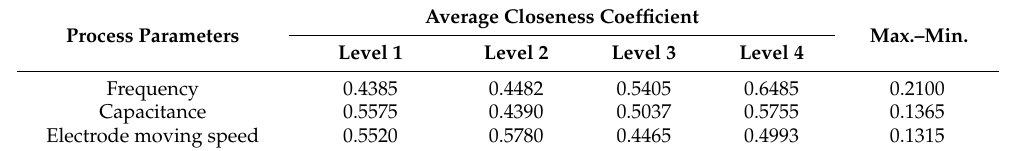
. Table 5. Response table for mean closeness coefficient 𝐶 (cid:3036)∗ . i